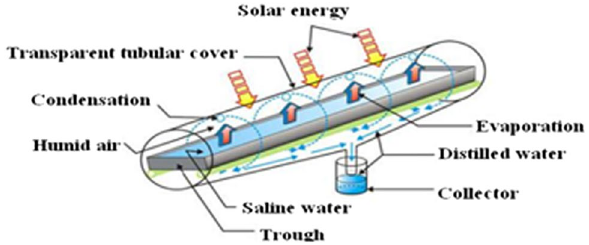
Fig. 1 Production principle of the